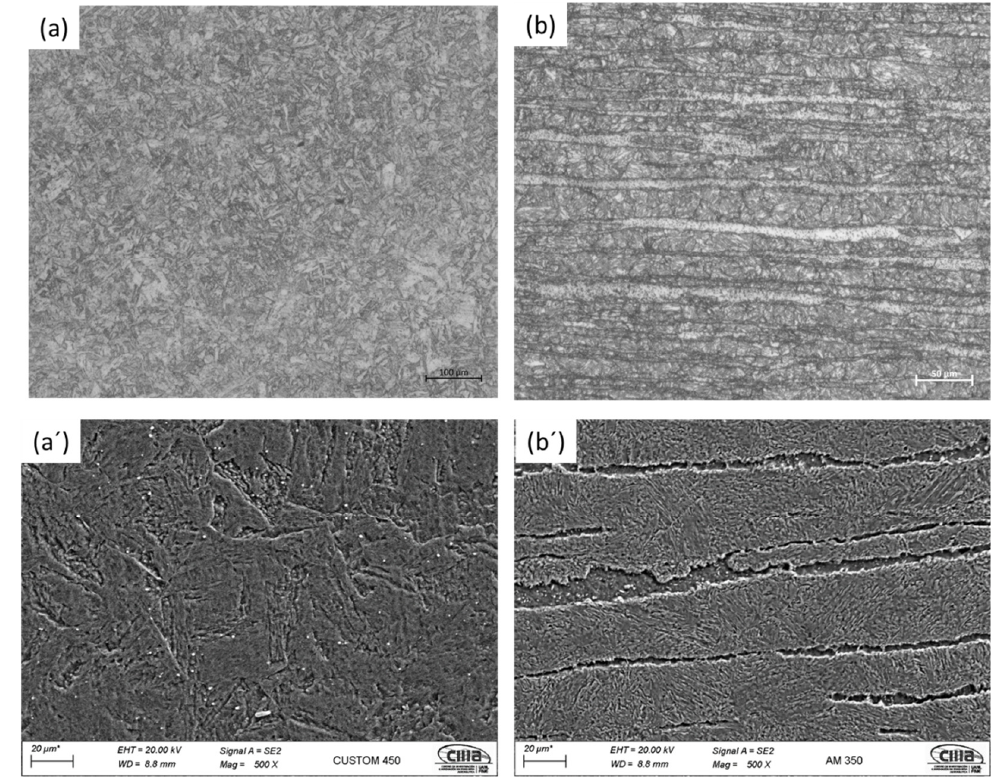
Figure 2. Microstructure of martensitic and semi-austenitic precipitation hardening stainless steel (initial conditions): ( a , b ) OM; ( a’ , b’ )